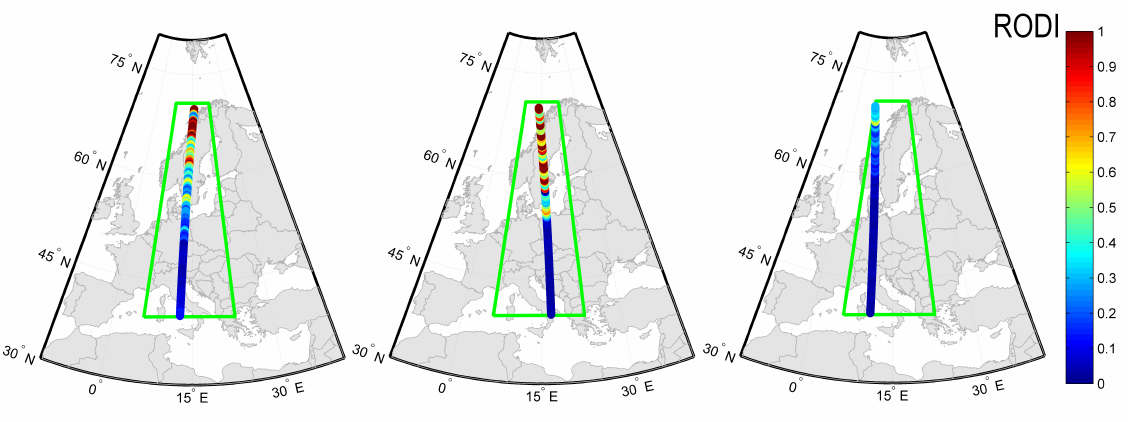
Figure 6. Swarm RODI measurements and positions for the selected cases, respectively, within the study area (green